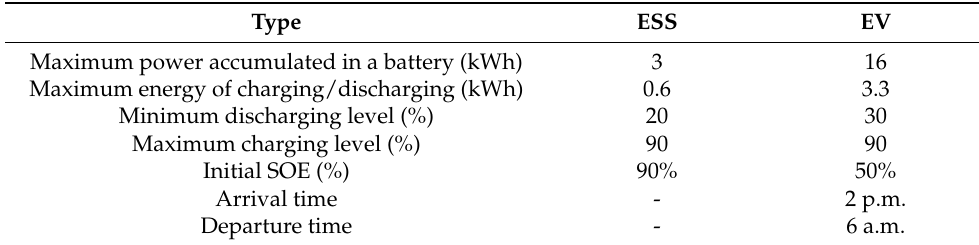
Table 2. Energy storage system (ESS) and electric vehicle (EV) data of each household. Type ESS EV Maximum power accumulated in a battery (kWh) Maximum energy of charging/discharging